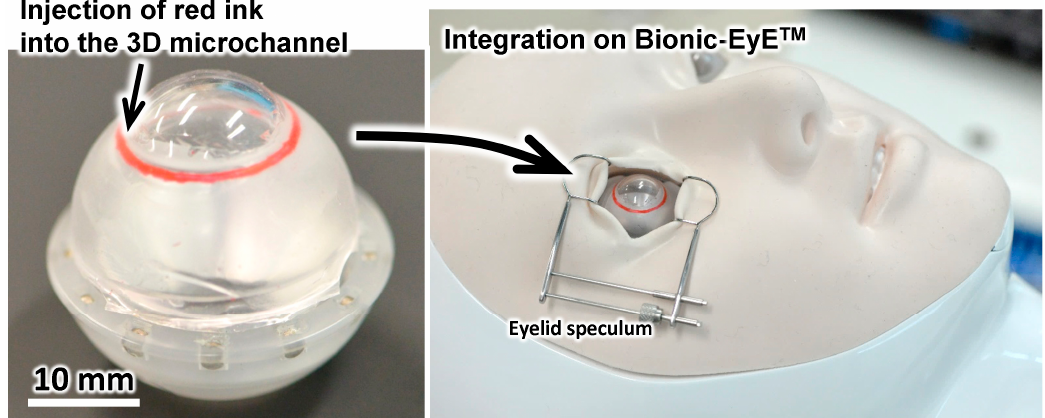
Figure 9. Photographs of the eye model installed on the Bionic-EyE TM for simulation of micro invasive glaucoma surgery.